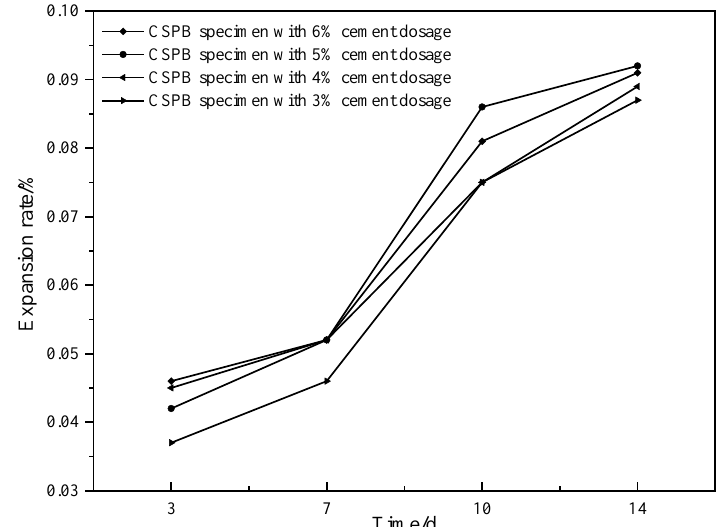
Figure 4. Accelerated simulation test results of the expansion rate of LMR-CSPB specimens.